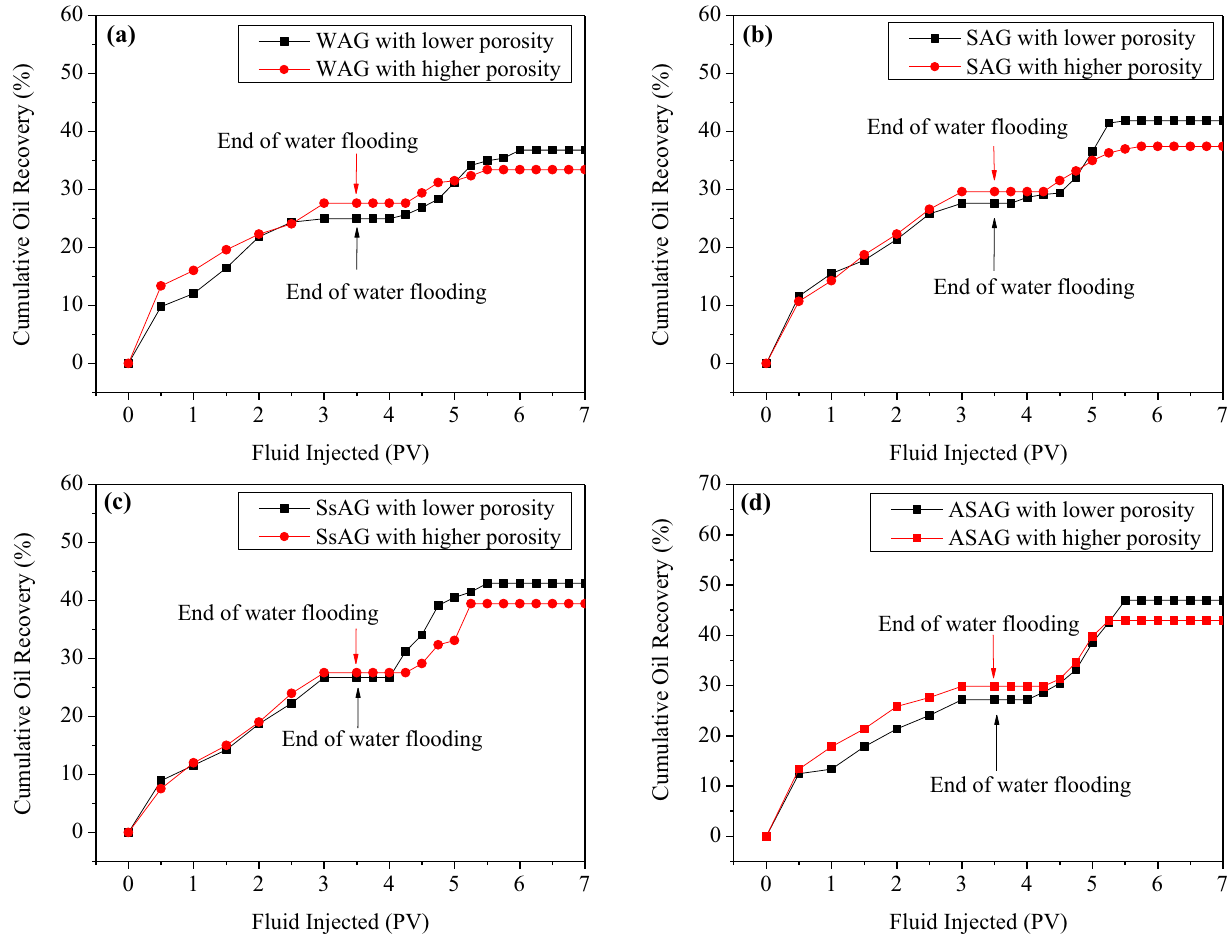
Fig. 6 Cumulative oil recovery (% OOIP) of the a WAG, b SAG, c SsAG and d ASAG experiments with core plugs having lower and